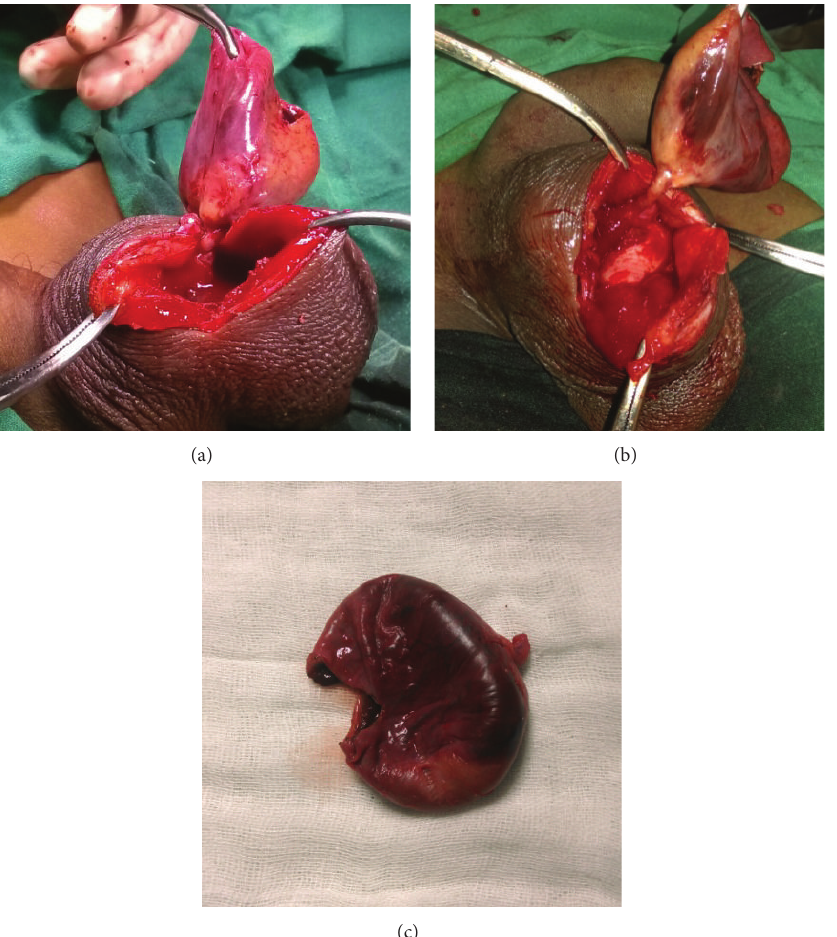
Figure 3: Torsion of appendix testis (a) arising from upper pole of right testis (b) and cyst with gangrenous changes in the wall with a stalk